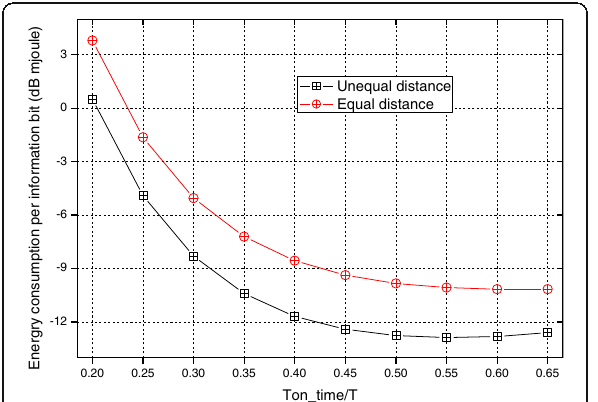
Fig. 18 The maximum energy consumption under UDNP and EDNP